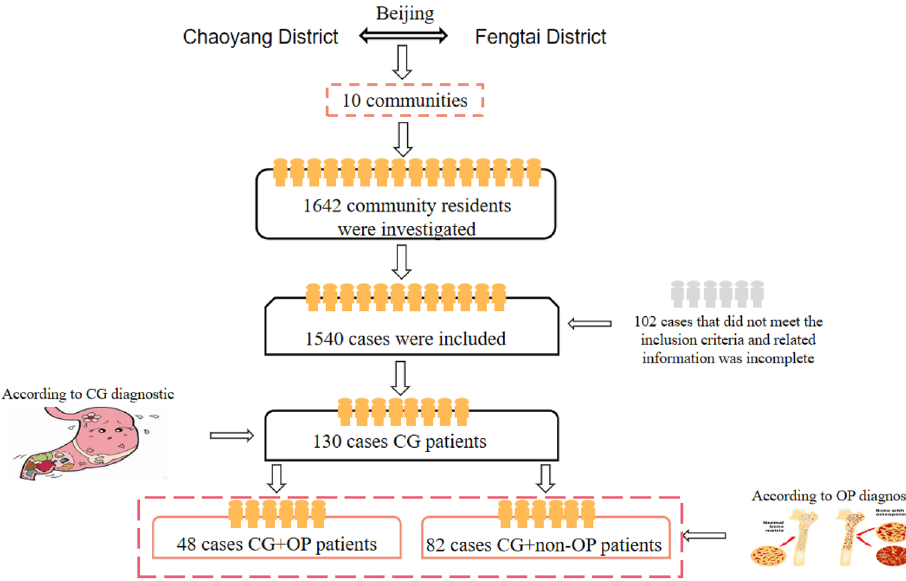
Figure 1. Crowd screening flow